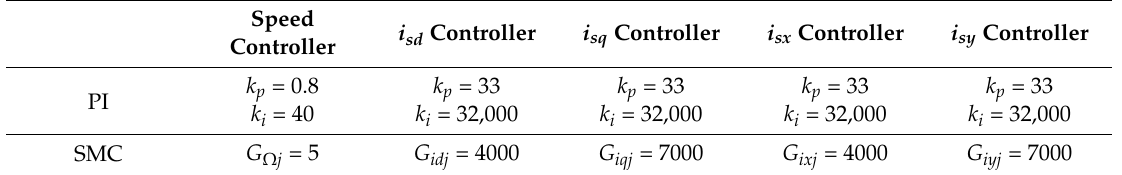
Table 2. PI and SMC